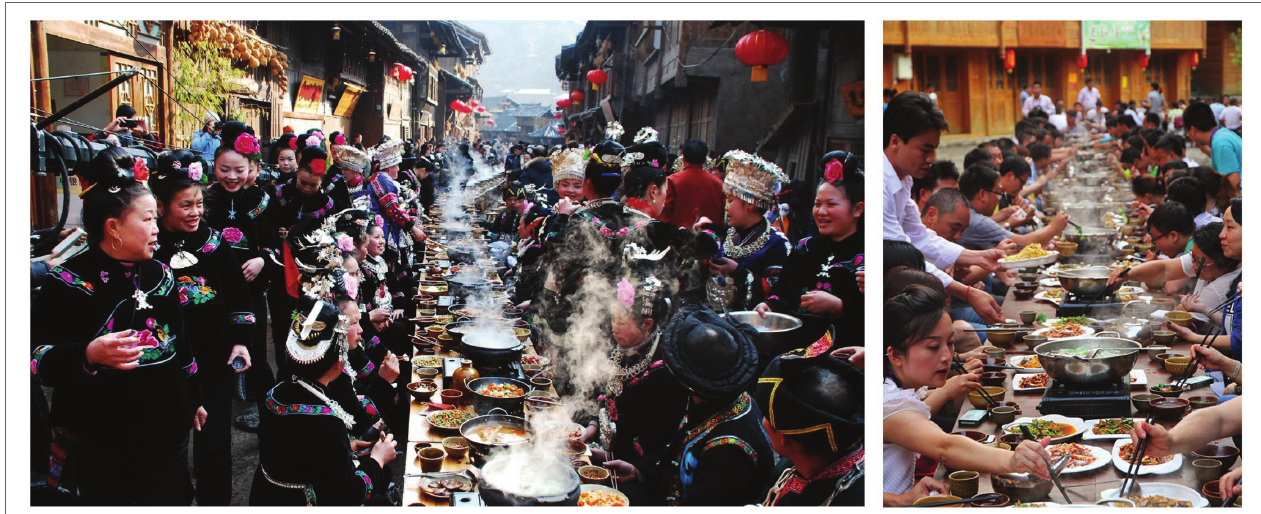
FIGURE 4 | Long Table Banquet for villagers ( left ) and visitors ( right ; Source: The official website of Xijiang Miao Village: http://www.xjqhmz.com/).